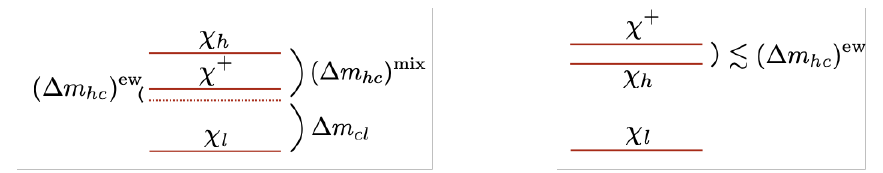
Figure 1 . Spectrum of dark fermions mixing through a Higgs portal. Left: \normal" mass hierarchy for sizeable portal coupling. Right: \inverted" hierarchy for small portal